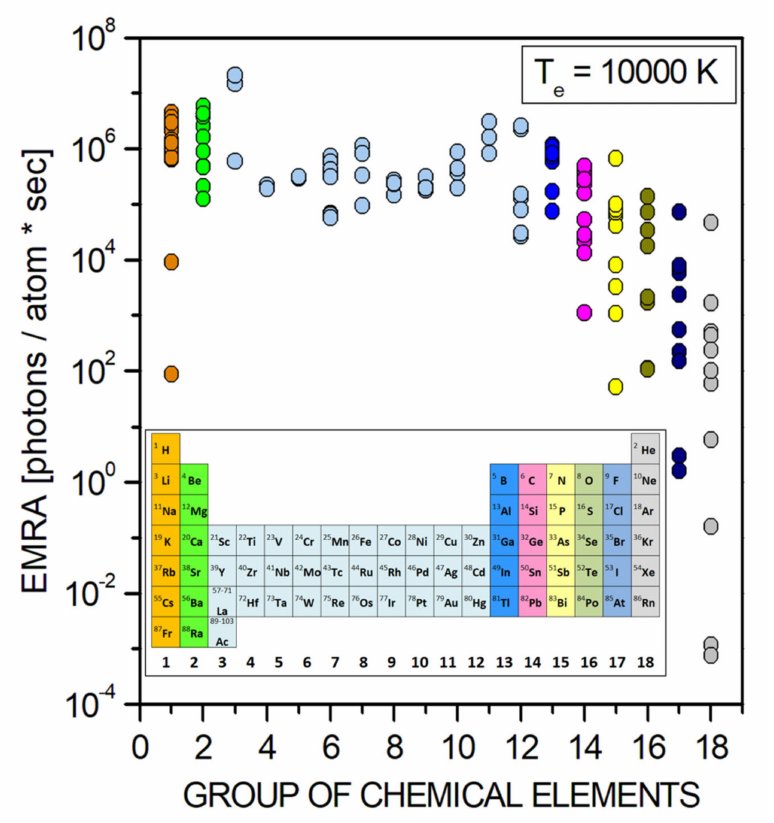
Figure 2. Emission rate EMRA of atoms in ideal plasma for most chemical elements in groups 1 to 18 of the periodic table (T e = 10,000 K). Groups are numbered according to the IUPAC scheme [54]. The sign “*” stands for